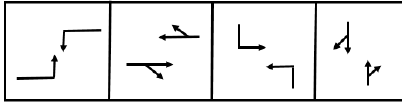
Figure 2. Phasing